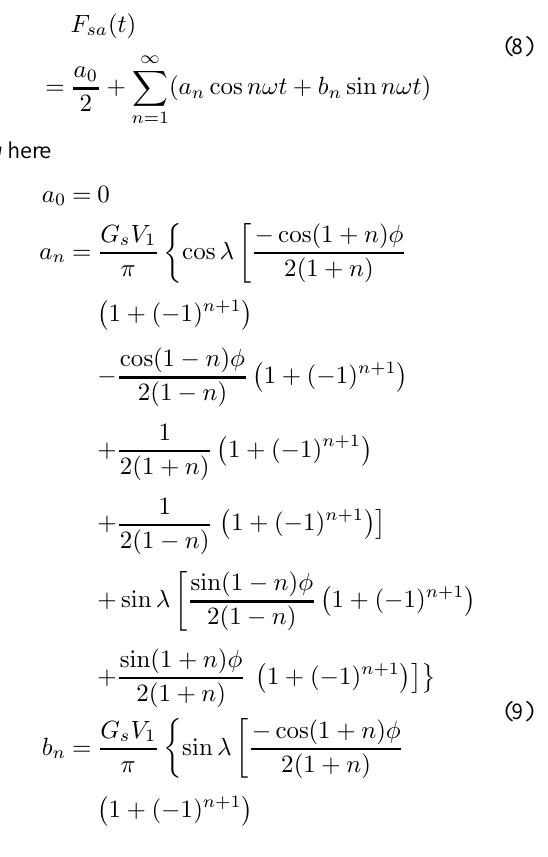
Fig. 7. Sprung mass acceleration (system response) power spectral density due to a 1.4 Hz pure tone excitation for a hard damper. The Fourier series expansion of Eq. (7)